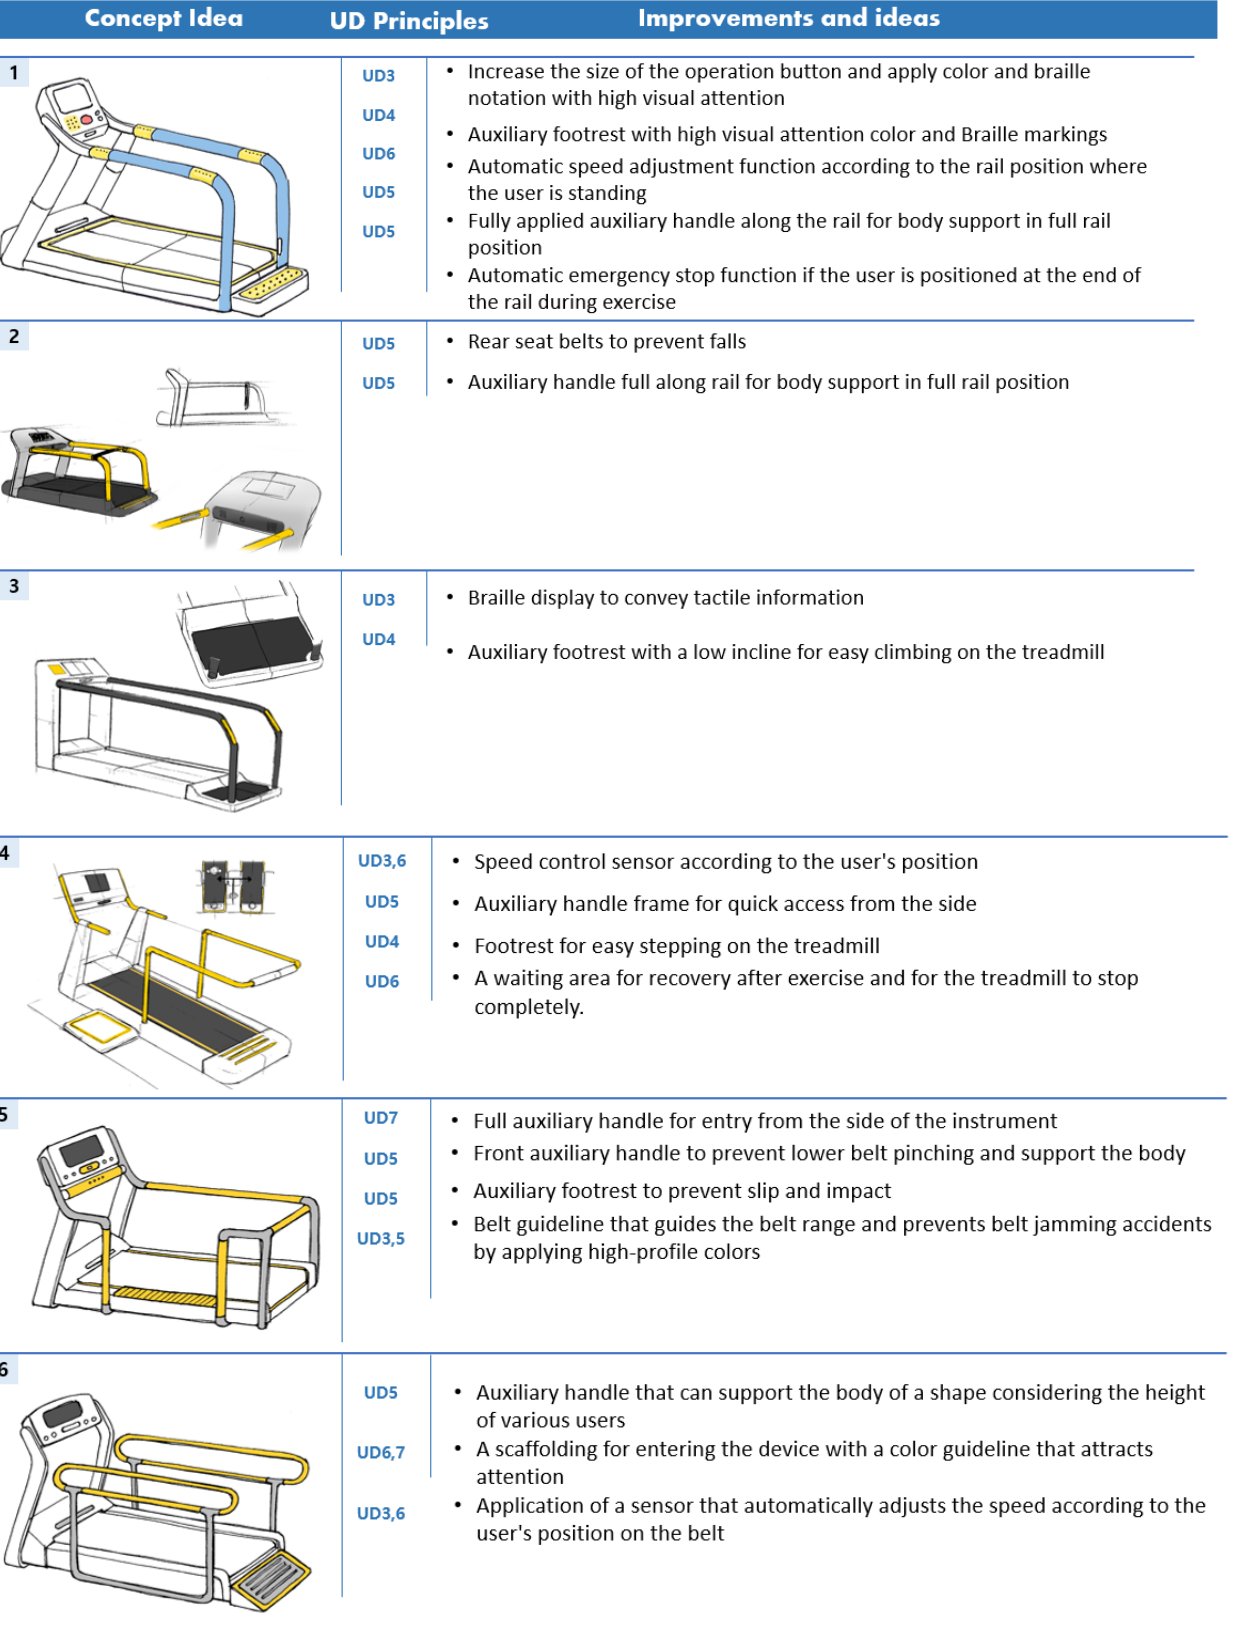
Figure 5. Six types of treadmill concept ideas applied with UD .